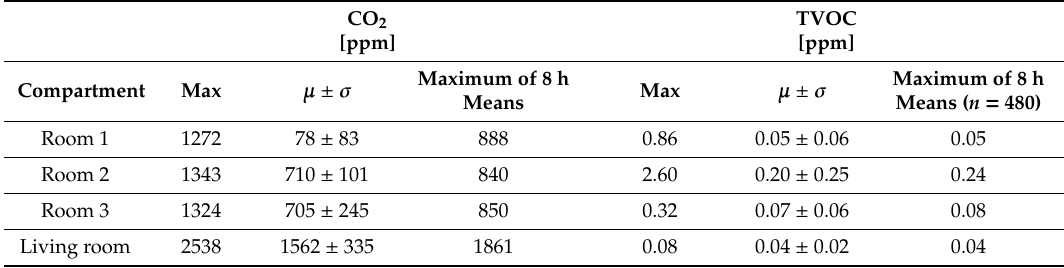
Table 9. Statistical analysis of the pollutants recorded in ECC 1 compartments: 2 nd trial (21 to 25 March).